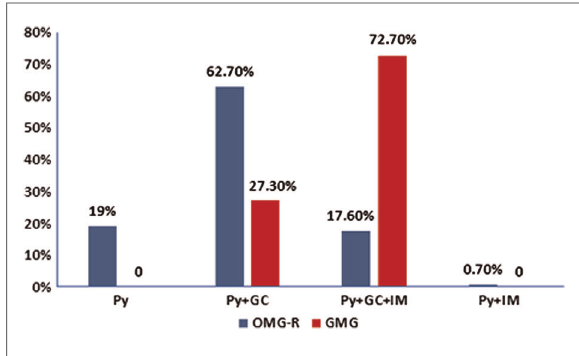
FIGURE 2 Treatment strategies distribution in remained ocular myasthenia gravis (OMG-R) and generalized myasthenia gravis (GMG) groups. The number of patients who were followed for longer than 2 years in each group (OMG-R or GMG) were calculated based on different treatment strategies. Py, treated with pyridostigmine only; Py+GC: treated with pyridostigmine and glucocorticoid; Py+GC +IM: treated with pyridostigmine, glucocorticoid and other immuosuppressants; Py+IM: treated with pyridostigmine and other